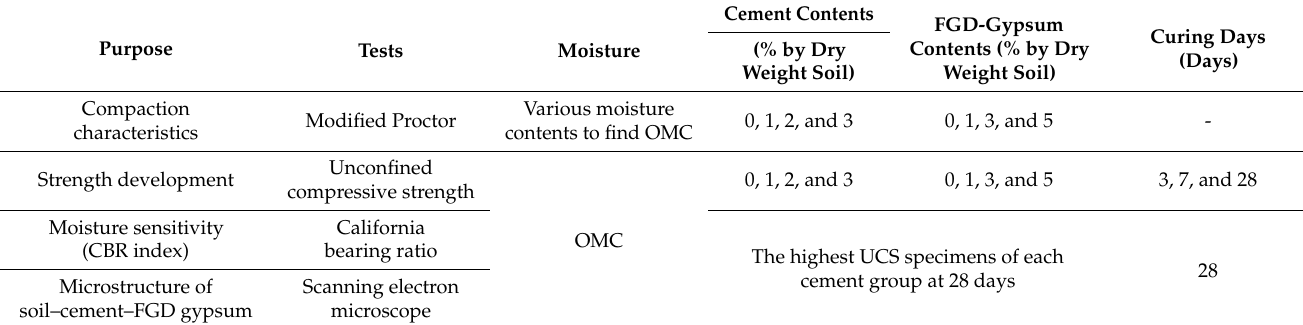
Table 5. Testing scheme.